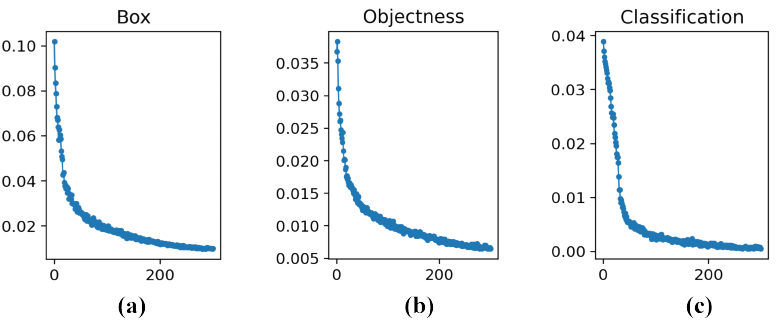
Figure 11. Training loss. ( a – c ) denote box regression loss, confidence loss, and classification loss, respectively.